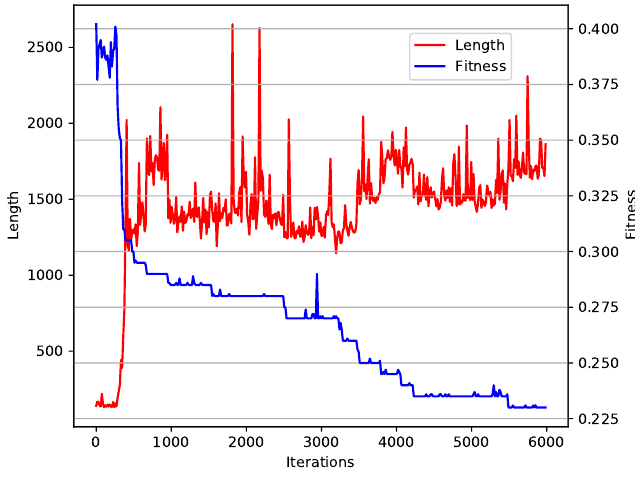
Figure 6. Average error (1 − fitness accuracy) vs. expression length for different generations based on random data with two letters in the alphabet, 100 words at each set of example and counter-example and word lengths between 2 and